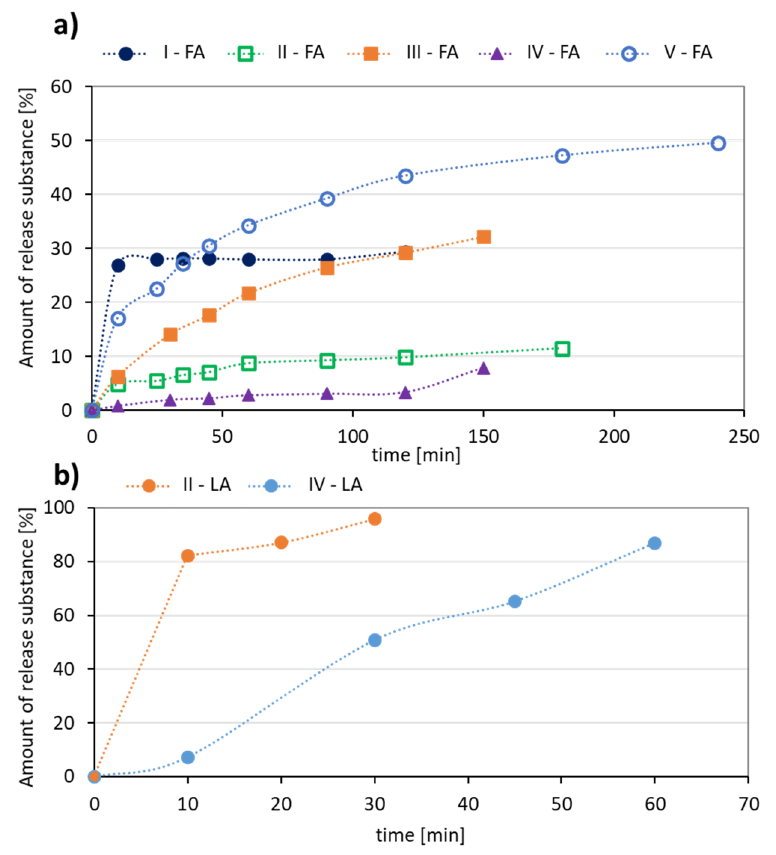
Figure 6. Kinetics profiles for ( a ) FA, and ( b ) LA release from the polymer conjugates.